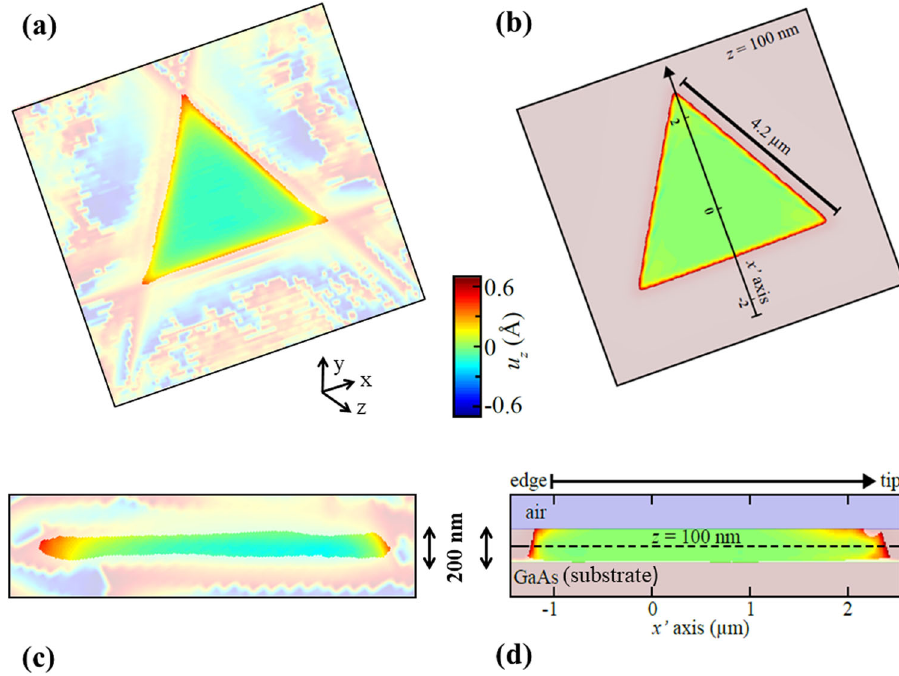
Fig. 3 Comparison between BCDI results and FEA simulations for a triangular structure obtained with the 5- µ m-side mask. a 2D slice through the 3D reconstructed out-of-plane atom displacement along a plane parallel to the micro-triangle surface and bisecting its thickness (i.e., at z = + 100 nm from the substrate upper face), the bright area is delimited by the intersection with the isosurface used in Fig. 2b; similar images (not shown) are obtained cutting with parallel planes at different heights. The displacement u z is related to the phase Φ z through the relation Φ z = 4 × (2 π / a z GaAsN ) × u z , where a z GaAsN is the out-of-plane lattice parameter of GaAs 1 − y N y ; the color scale is in Å . b FEA simulation corresponding to the displacement map of a , obtained as described in the “ Methods ” section and in the Supplementary FEA section, color scale is in Å . c Displacement map obtained cutting the triangle with a plane perpendicular to the surface, and passing by one vertex and bisecting the opposite edge, the vertex is at the right of the image, the substrate-side at the bottom. d FEA simulation corresponding to the displacement map of c . The full amplitude and displacement volumes simulated by FEA are available upon request from the